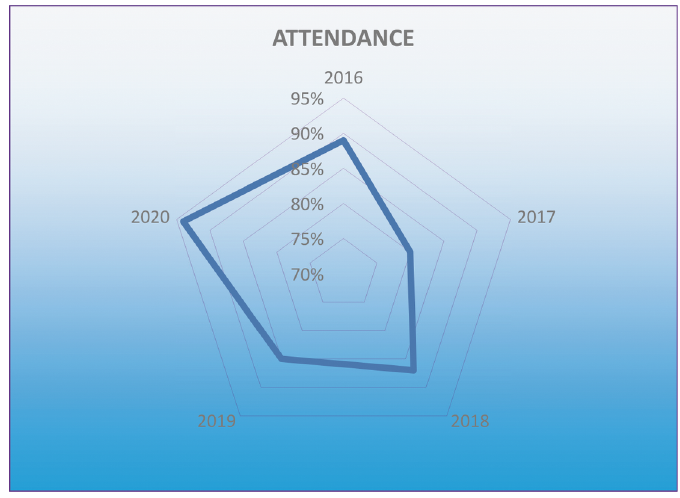
Figure 1. Comparative assistance period 2016 to 2020. Own